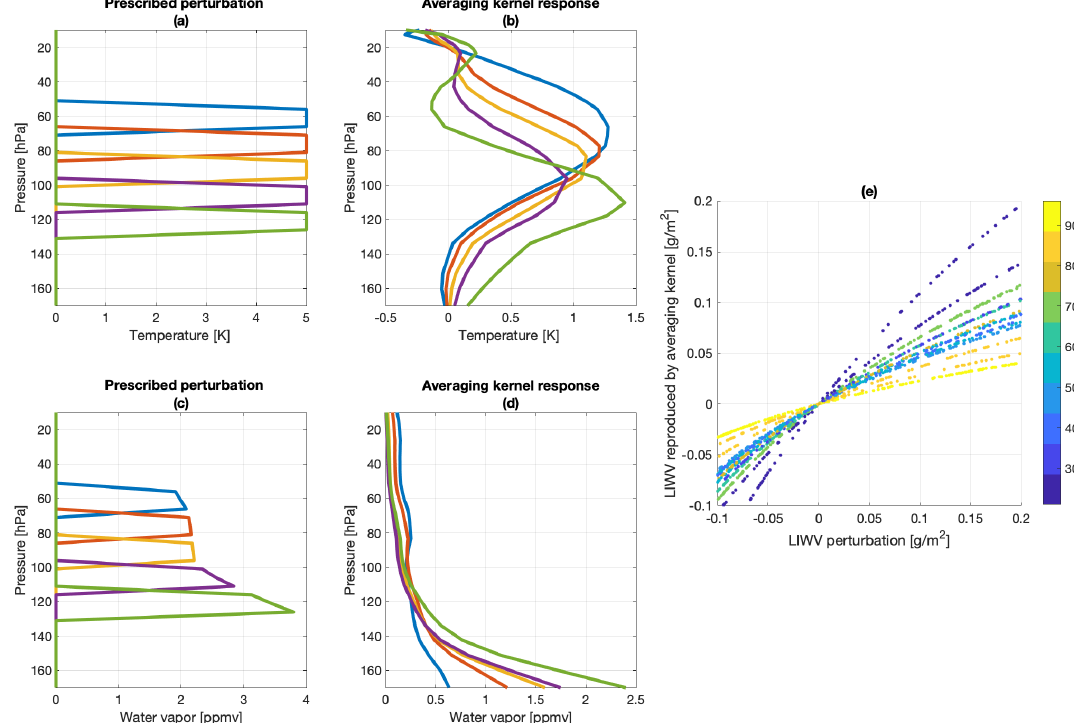
Figure A3. Averaging kernel responses to temperature and water vapor perturbation in thin layers. (a) Prescribed perturbation and (b) the response of averaging kernel in temperature (K). (c) Prescribed perturbation and (d) the response of averaging kernel in water vapor (ppmv). (e) LIWV perturbation (g/m 2 ) between 100 and 20hPa reproduced by averaging kernel, color-coded for vertical pressure intervals (hPa) where the perturbation is